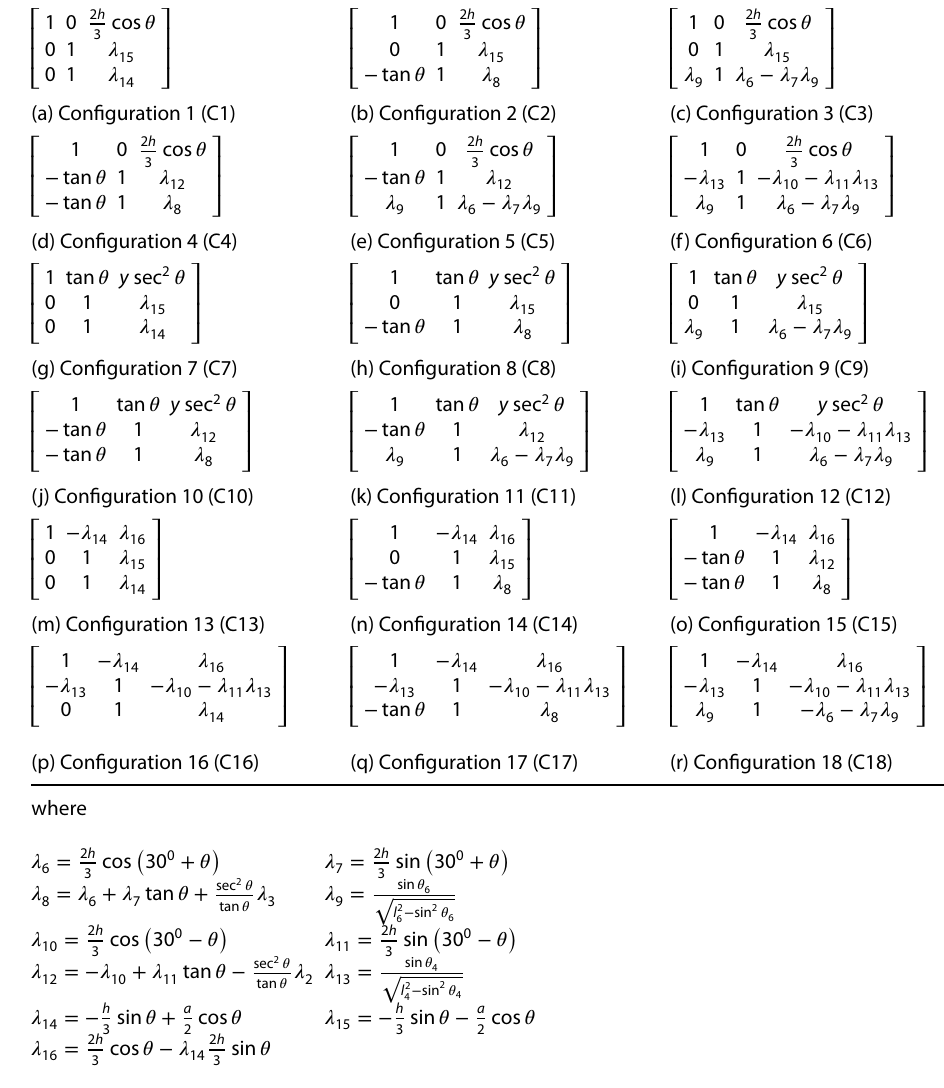
Table 1 Jacobian matrix (J) of the family of U-shape fixed-base planar parallel manipulators